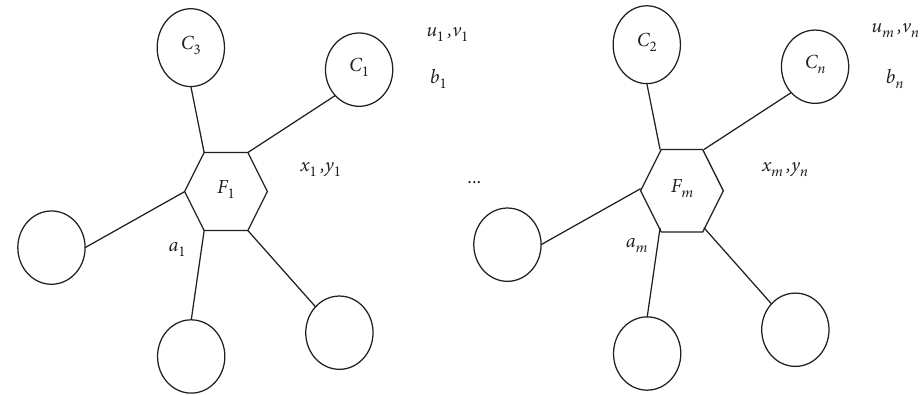
Figure 2: Schematic diagram of facilities-customer location